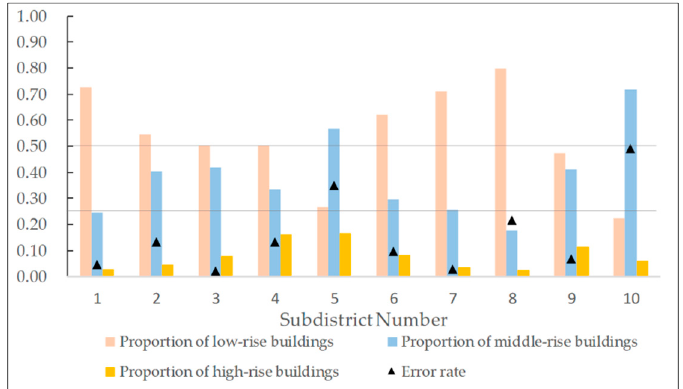
Figure 9. Proportion of buildings with different floor heights.